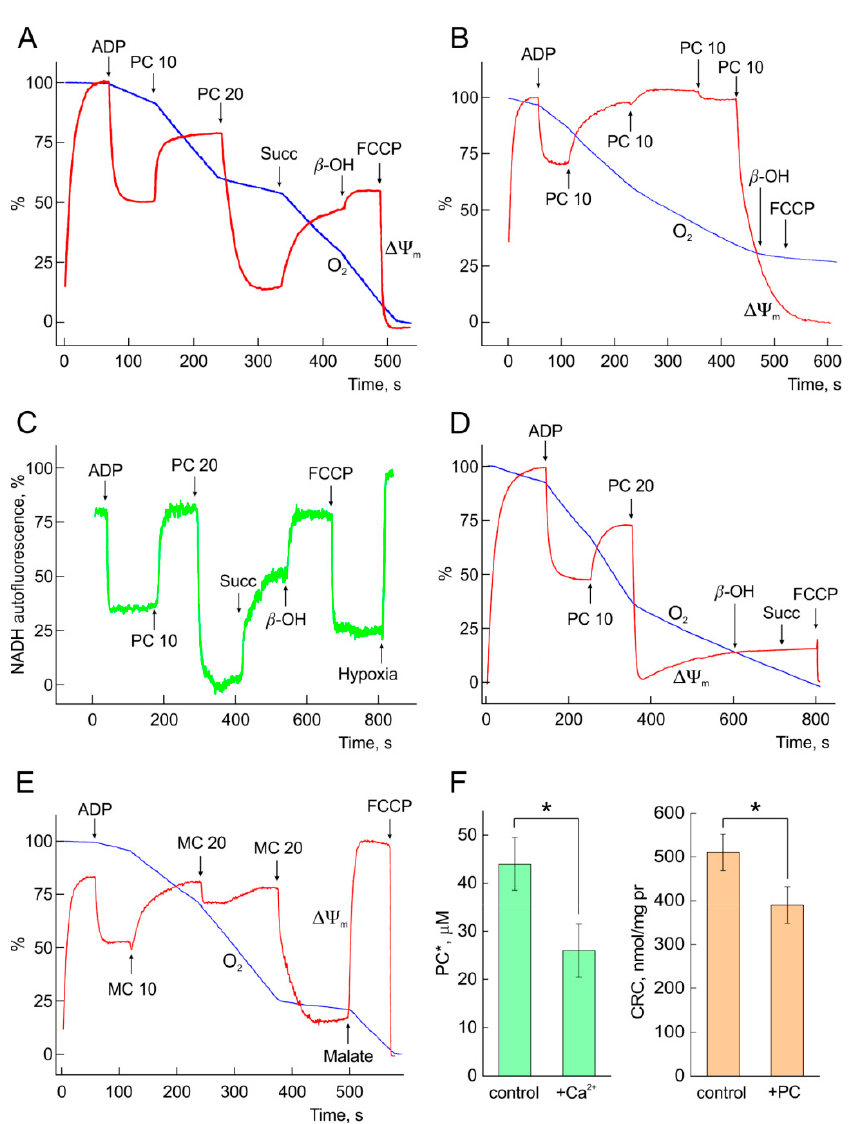
Figure 5. Concentration-dependent e ff ects of PC or MC on OXPHOS in isolated mitochondria. Activation, reversible and irreversible inhibition of OXPHOS and TCA cycle by PC and MC in the experiments on isolated rat heart mitochondria. In panels ( A , B , D , E ) are presented mitochondrial oxygen consumption (O 2 traces, blue) and potential ( ∆Ψ m , red). Panel ( C ) depicts the alterations of mitochondrial NAD(P)H fit to the experiment of panel ( A ). Oxygen consumption in a mitochondrial suspension was measured by Clark-type oxygen electrode in a closed chamber of 2 mL wth 0.3–0.6 mg mitochondrial protein in ml, under continuous stirring. Mitochondrial potential ( ∆Ψ m ) changes were evaluated by measuring rhodamine-123 (Rh-123) fluorescence, except for panel F where TPP + was recorded with TPP + selective electrode in open chamber. ADP (0.5 mM) was added at the beginning of each experiment to preset steady state mitochondrial respiration (in presence of hexokinase and glucose in incubation medium). Malate (1 mM) plus α -ketoglutarate (5 mM) were used as substrates in the experiments in panels ( A , C ). Glutamate (10 mM) plus pyruvate (0.5 mM) were used as substrates in the experiments in panels ( B , D , E , F ). Values of PC and MC are in µ M. Panels ( A , C , E ) show the examples of reversible inhibition of OXPHOS and TCA cycle by PC (panels A , C ) and MC (panel E ). Here, addition of succinate (5 mM), malate (5 mM), and β -oxybutyrate (b-OH, 10 mM) provide reactivation of the respiration (slope of O 2 trace, red), rise of ∆Ψ m (blue) and NADH (green). Meanwhile, panels ( B , D ) illustrate irreversible inhibition of OXPHOS by PC excess when addition of succinate and β -oxybutyrate is not e ff ective. Panels A to E display one of 3 independent experiments. Panel ( F ) depicts average for 5 experiments values of both, threshold concentration of PC required for mPTP opening (PC*) and of mitochondrial calcium retention capacity (CRC). This panel describes the e ff ect of 20 µ M Ca 2 + on PC* and, vice versa, of 20 µ M PC on CRC. * p < 0.05 with ANOVA post hoc Bonferroni test. p < 0.01 with Student’s t